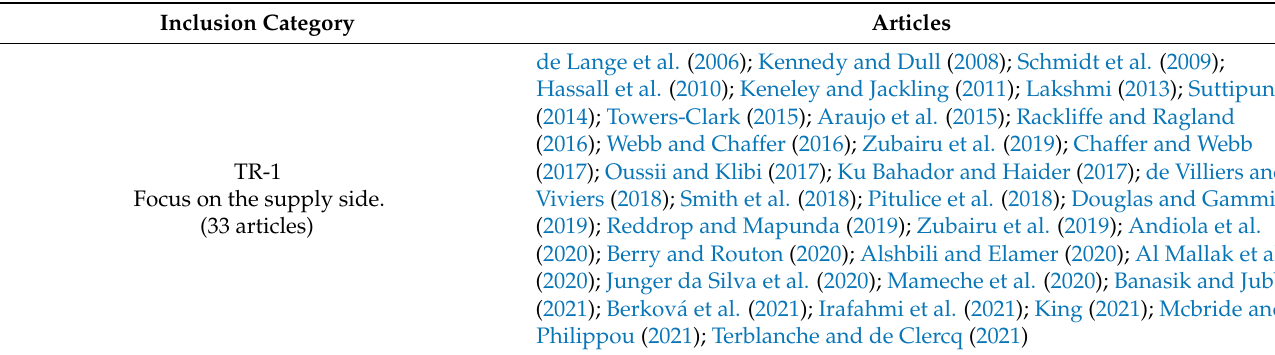
Table 3. Articles by inclusion